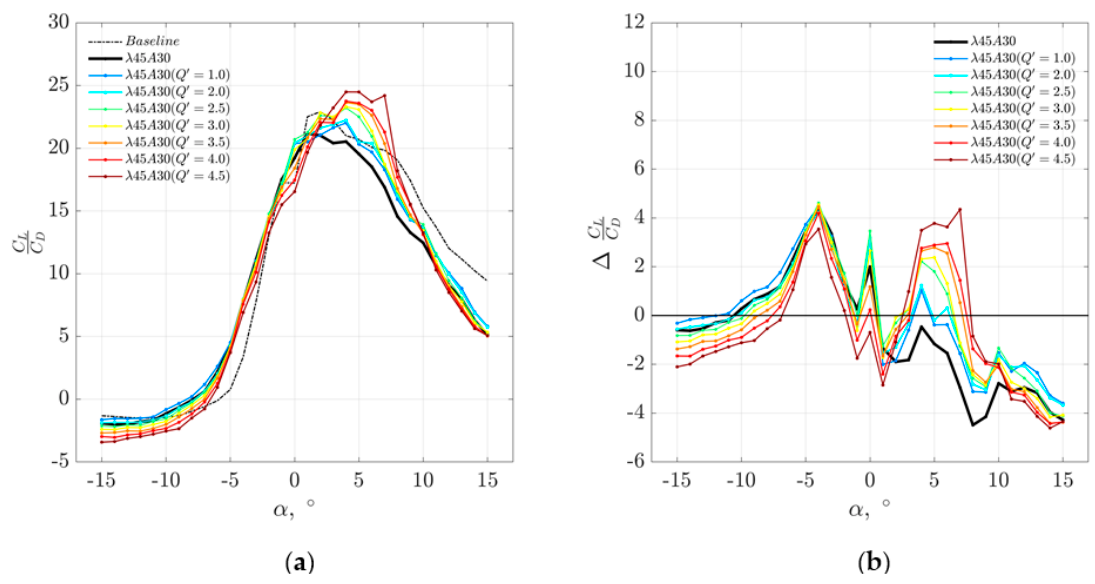
Figure 14. Comparison of the ( a ) C L /C D as a function of α produced by the baseline and hybrid ( λ 45 A 30 + blowing Q ‘ ) leading edge device at U = 25 ms − 1 . The leading edge blowing range covers 0.0 (serration only) ≤ Q ‘ ≤ 4.5 L/min, and ( b ) The corresponding ∆ C L /C D as a function of α , where ∆ C L /C D is the difference in C L /C D between the hybrid ( λ 45 A 30 + Q ‘ = 0.0–4.50 L/min) and the baseline.